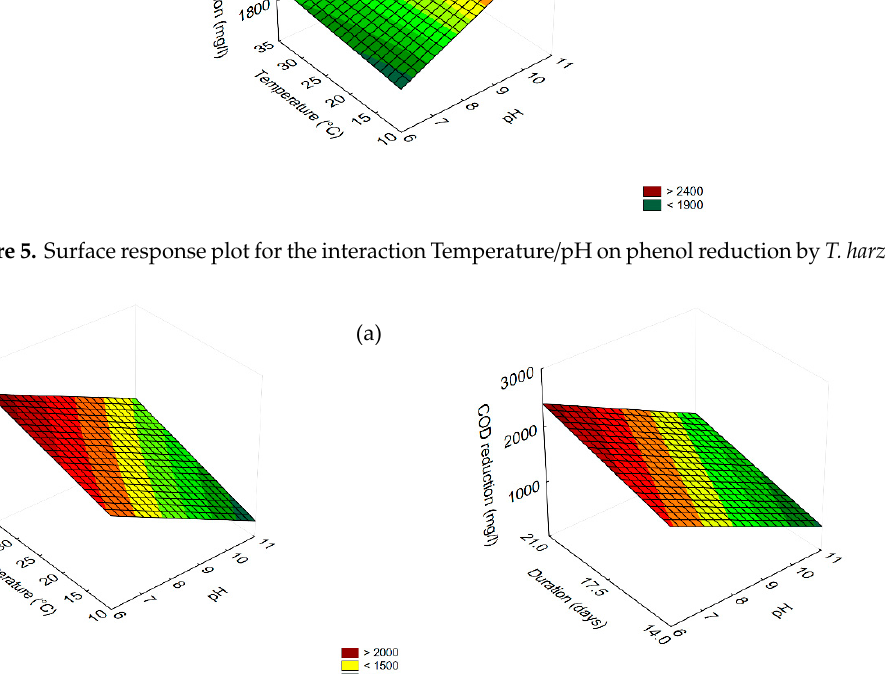
Figure 5. Surface response plot for the interaction Temperature/pH on phenol reduction by T. harzianum .